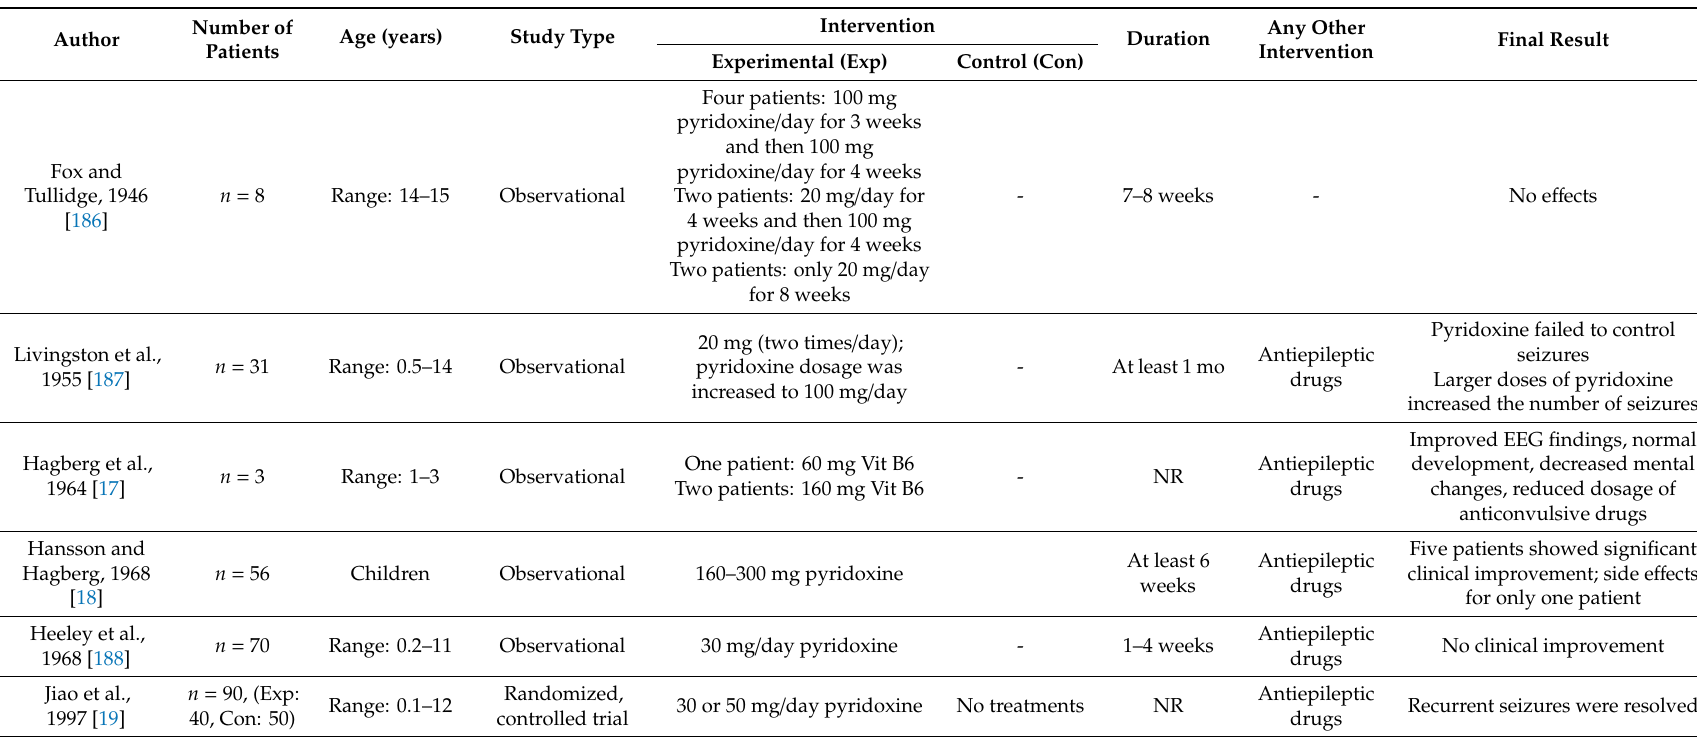
Table 4. Clinical studies assessing the e ffi cacy of vitamin B6 in patients with